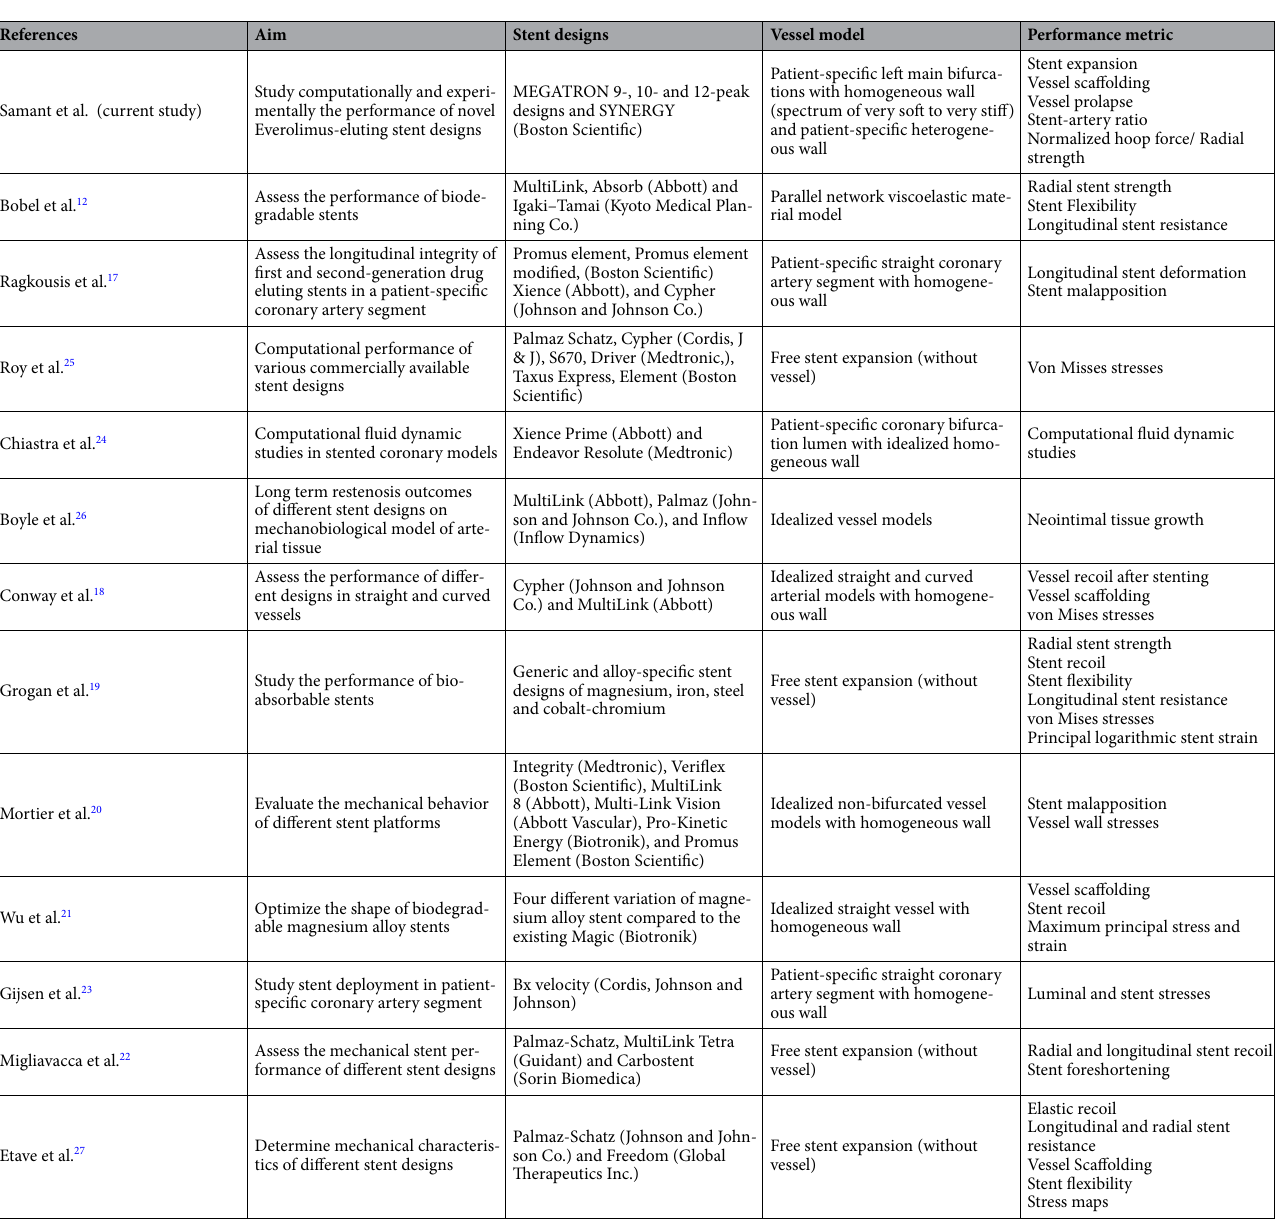
Table 1. Computational stent modeling